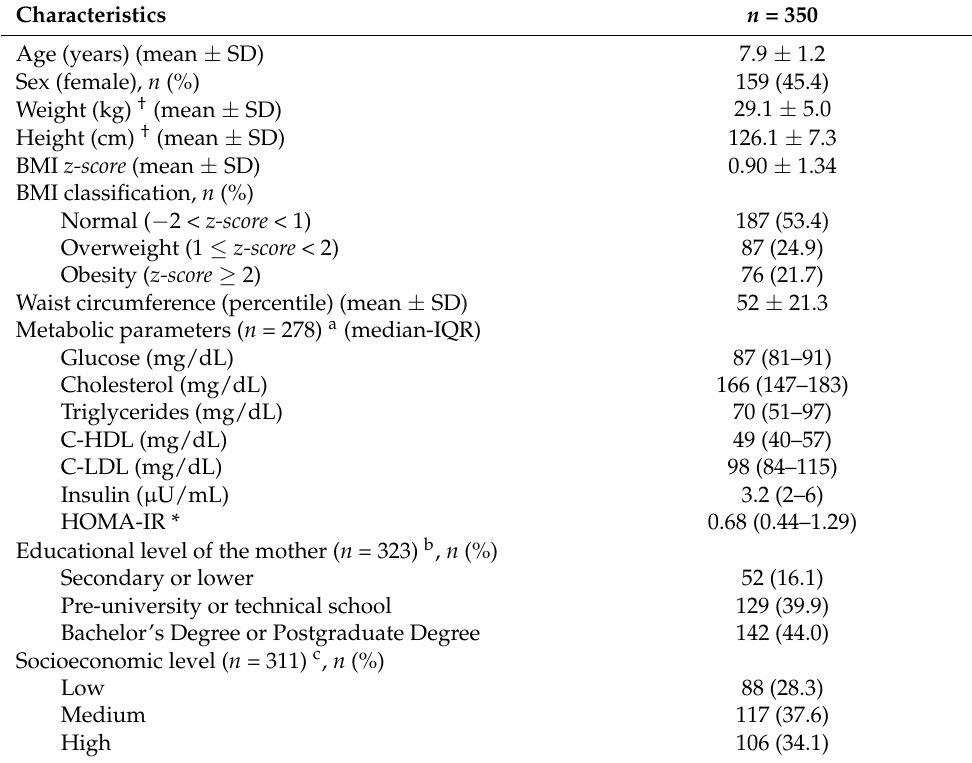
Table 1. Characteristics of the study